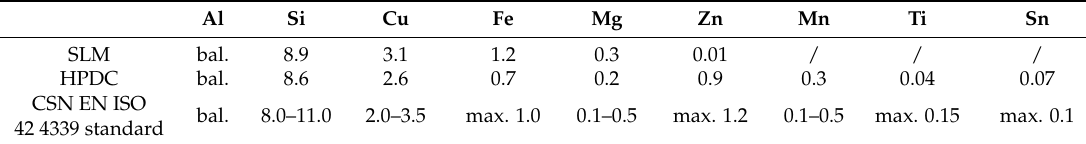
Table 1. Chemical composition (wt.%) of the AlSi 9 Cu 3 Fe alloy.